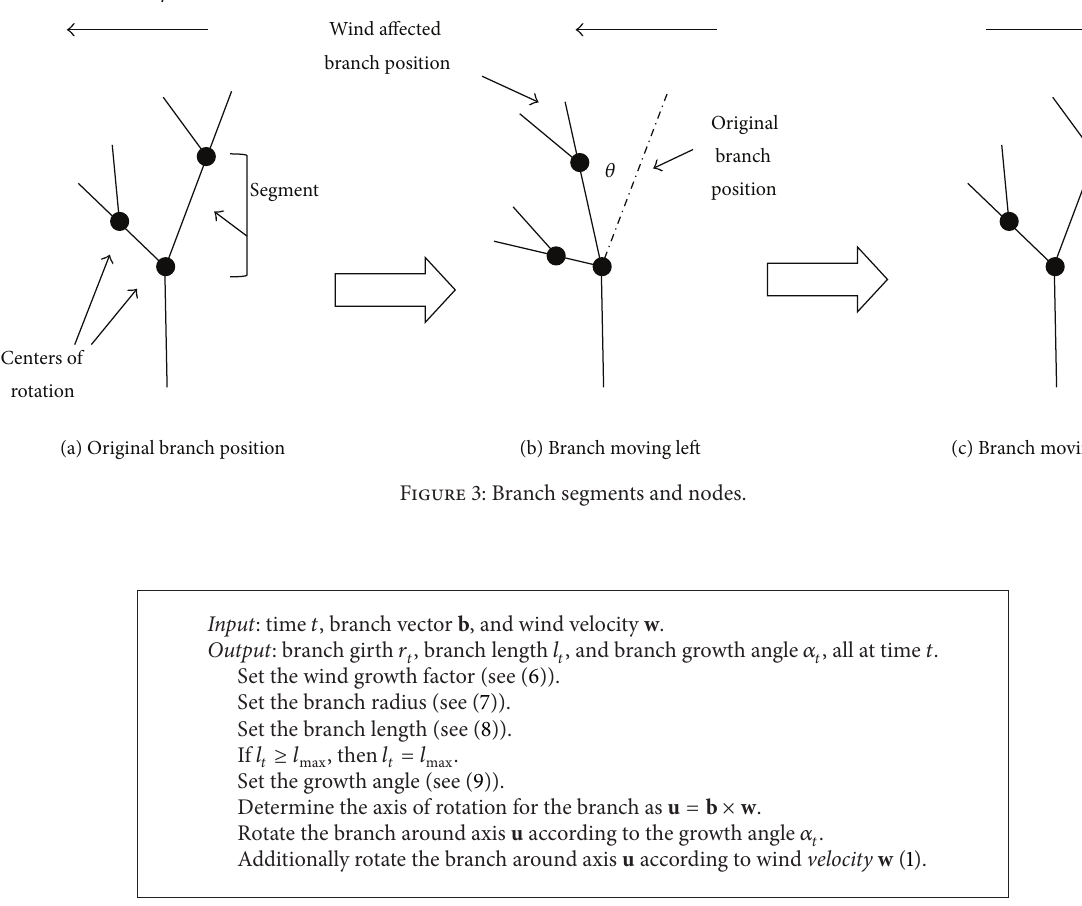
Algorithm 1: The general algorithm for branch growth and